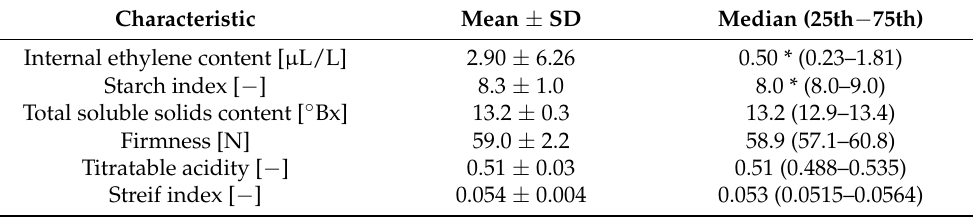
Table 1. Characteristics of Idared apples assessed directly after